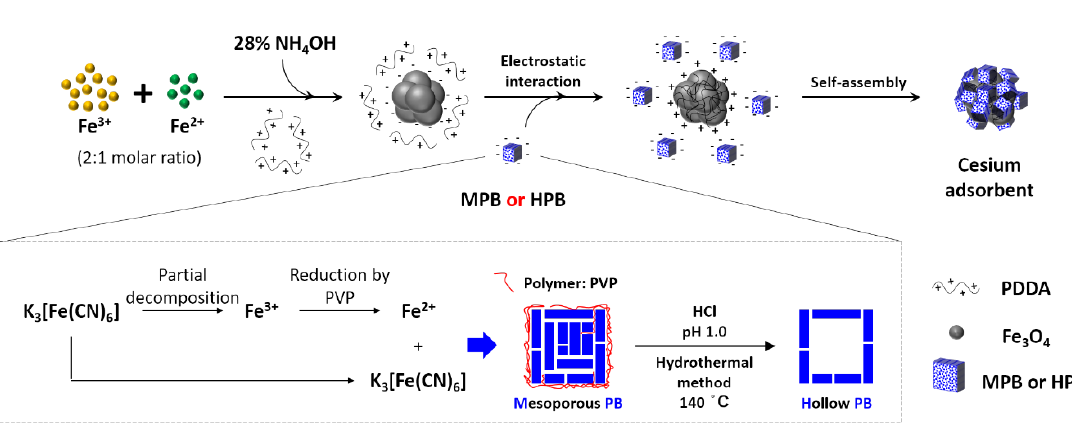
Figure 1. Schematic diagram of the synthesis of hollow Prussian blue (HPB)@ poly(diallyl dimethyl ammonium chloride) (PDDA)@Fe 3 O 4 nanocomposites.